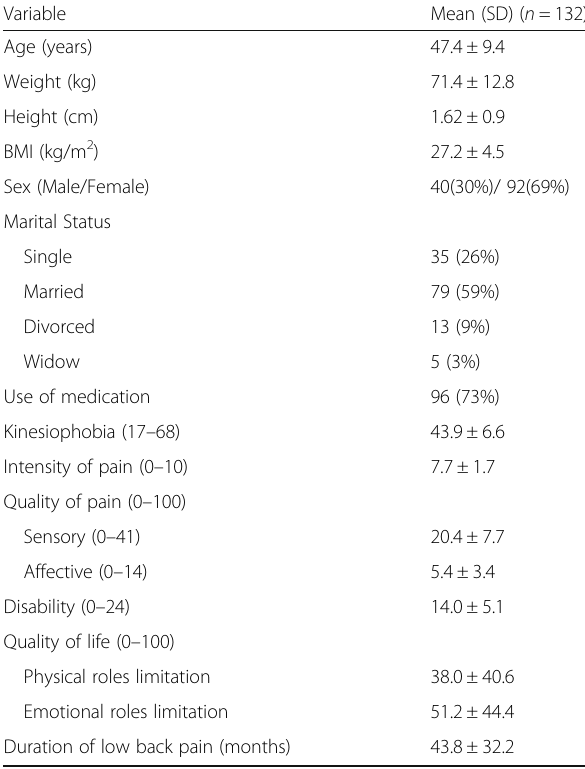
Table 1 Demographic and clinical characteristics of the